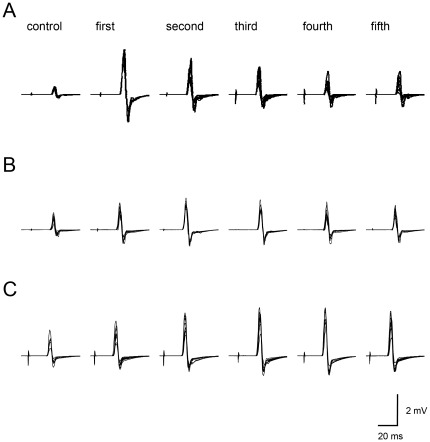
Typical recordings of MEPs in FDI during experiment 1 (A), 2 (B) and 3 (C).These waveforms were obtained from three different participants. Ten traces were superimposed for each waveform.